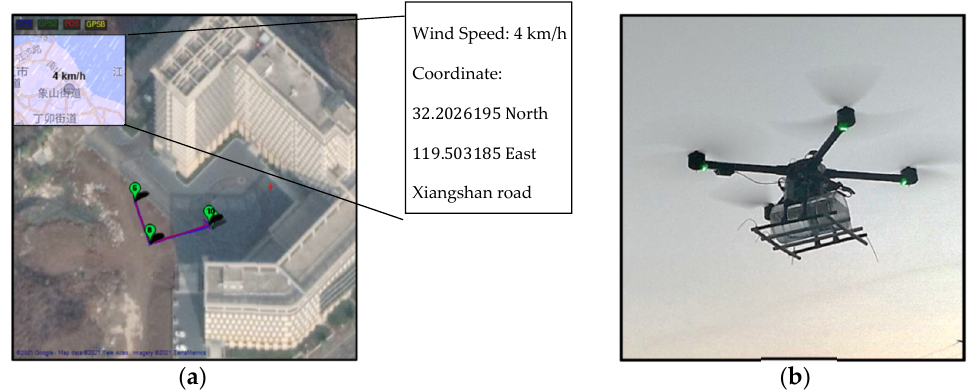
Figure 11. UAV experiment mission at 215° wind direction. ( a ) Ground station view of the flight path and the experiment field; ( b ) UAV with the liquid tank.